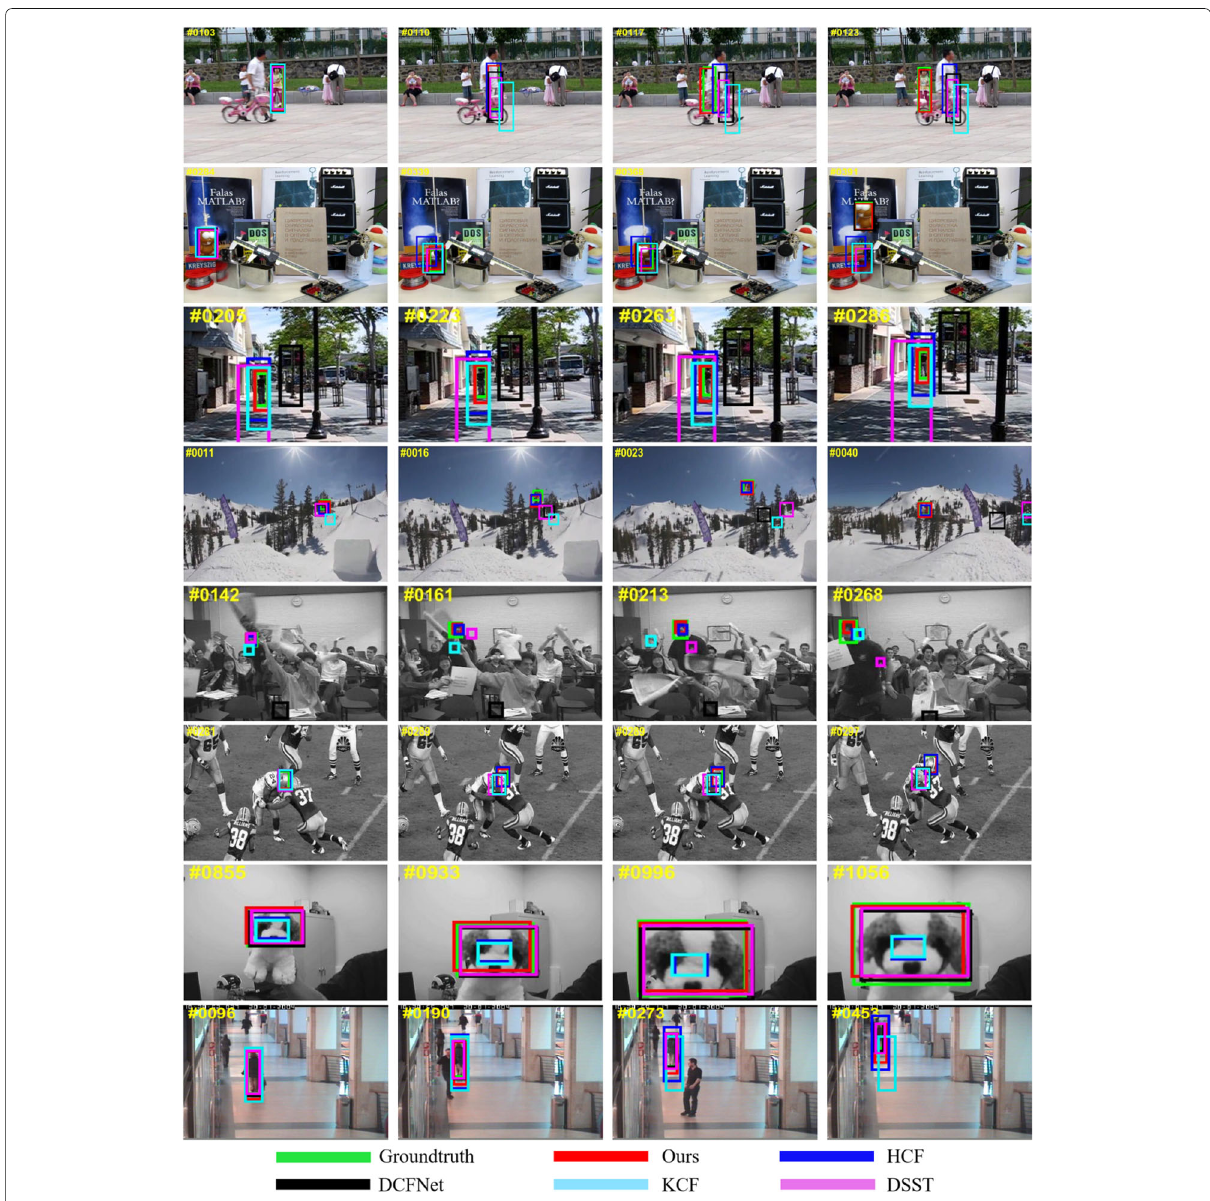
Fig. 9 Qualitative evaluation of the proposed method, DCFNet, DSST, KCF, and HCF on seven challenging sequences